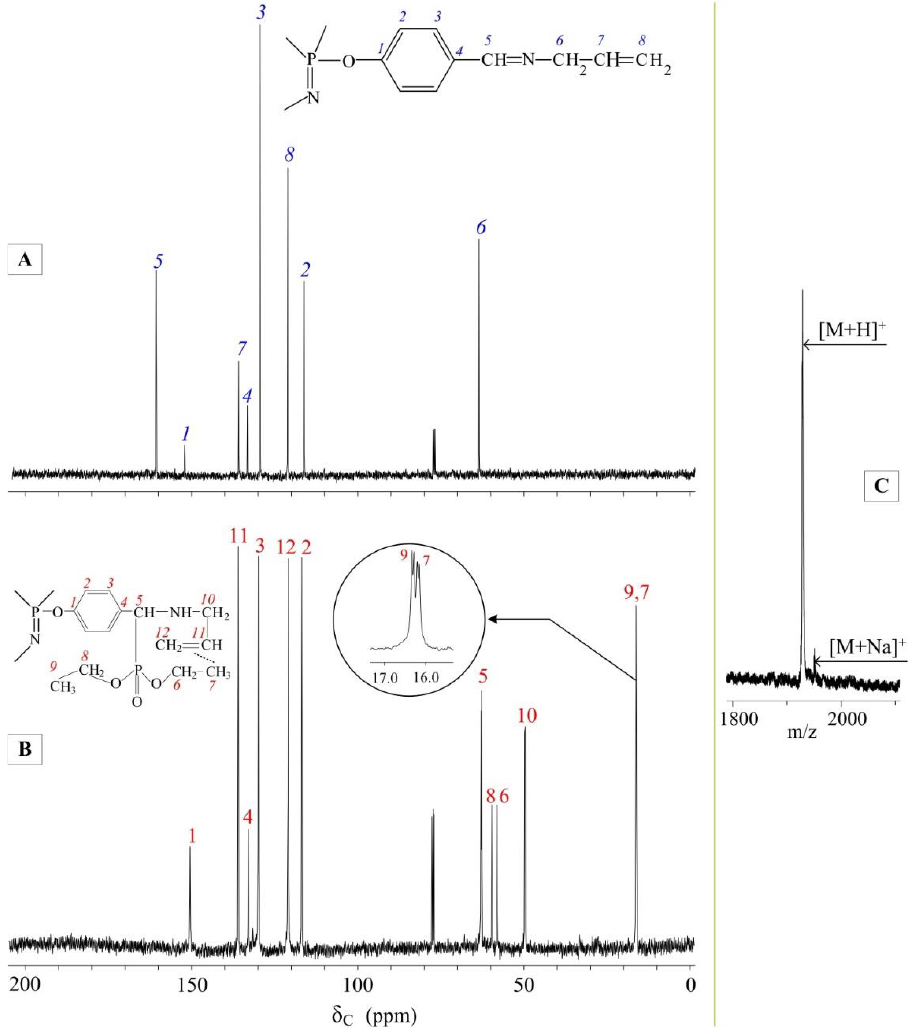
Figure 3. 13 C NMR spectra of APP ( A ) and extractant ( B ) and MALDI-TOF mass spectrum of extractant ( C ).